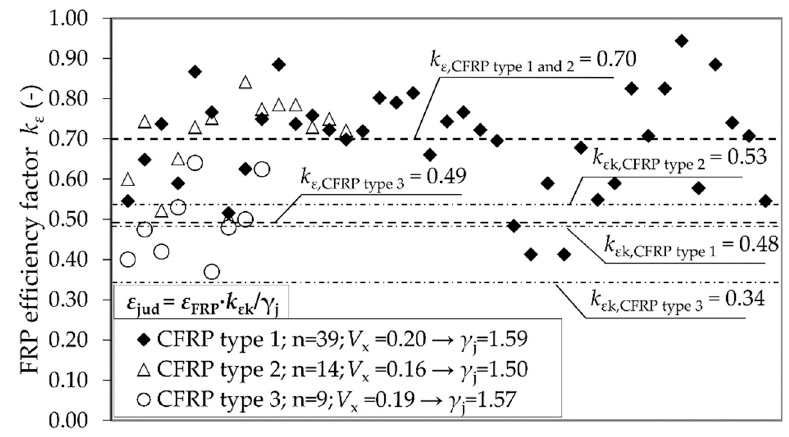
Figure 8. Values for k ε determined from tests with different CFRP materials, calculated characteristic values k ε k (according to EN 1990), and partial safety factors γ j (according to fib Bulletin 80 [27]).